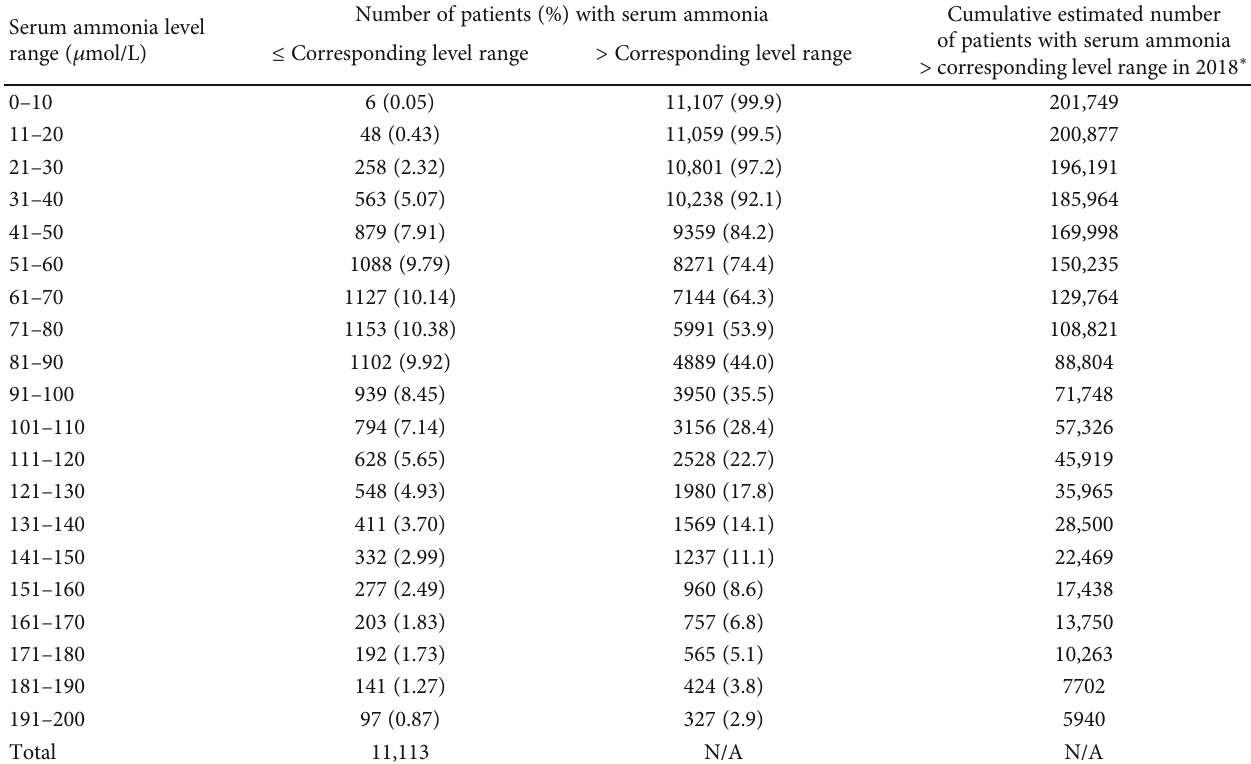
Table 4: Serum ammonia levels in patients with HE.